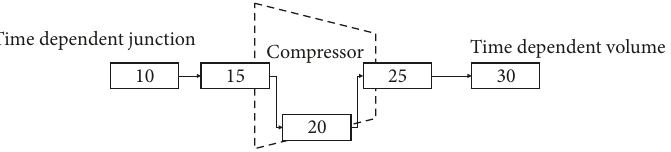
Figure 12: Nodalization of GAMMA code